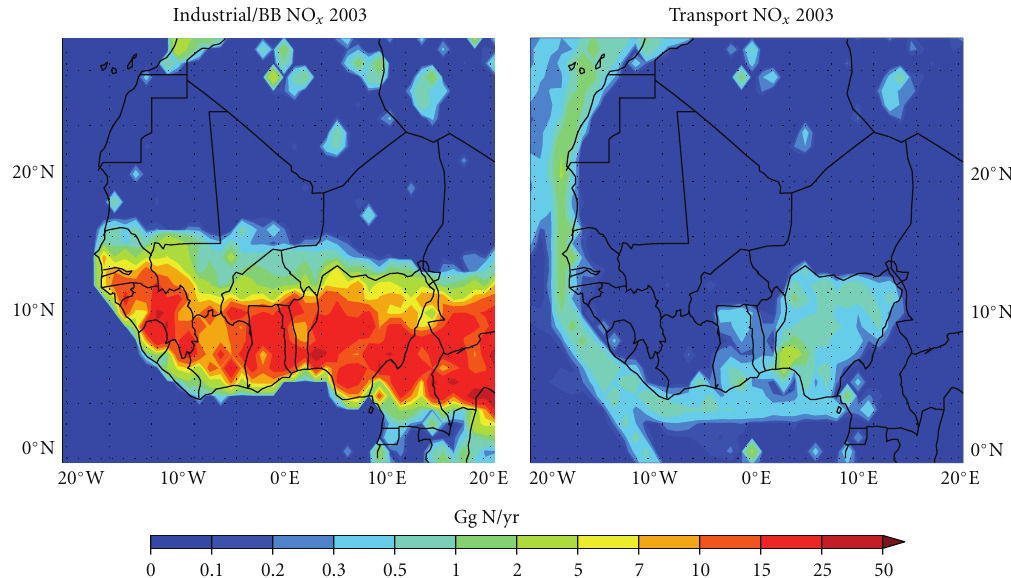
Figure 1: The annual distribution of anthropogenic NO x emissions for 2003 in West Africa. The left panel shows non-transport-related NO x emissions including biomass burning emissions, and the right panel shows transport-related NO x emissions.